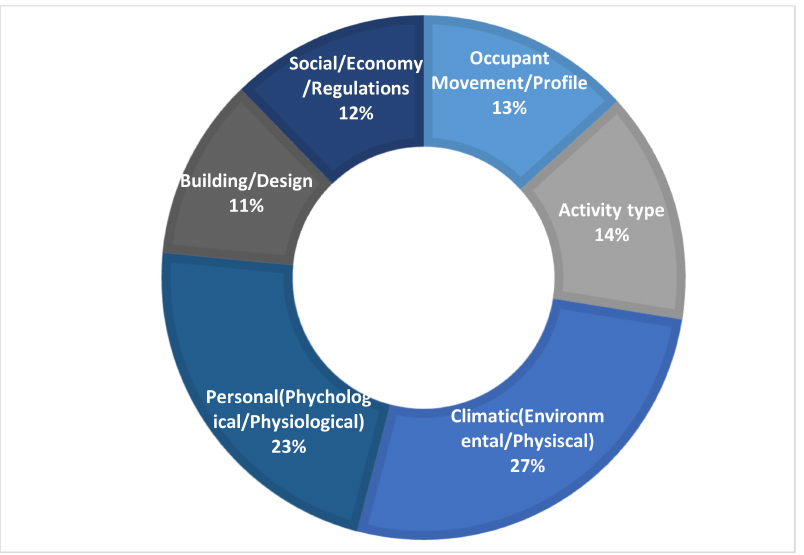
Figure 9. Key influential parameters of occupant energy conservation (EC)